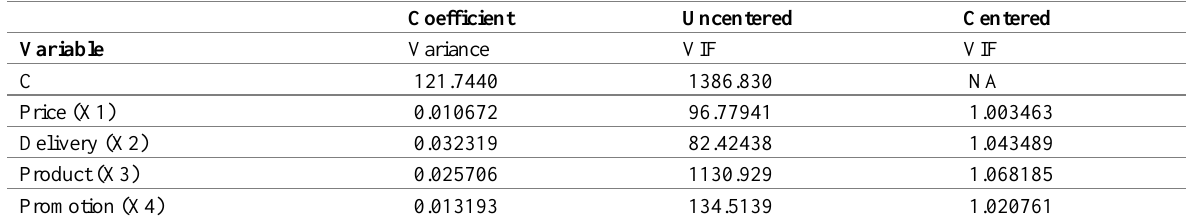
Figure 1: Normality Test Result Jarque-Bera Table 1: Multicollibearity